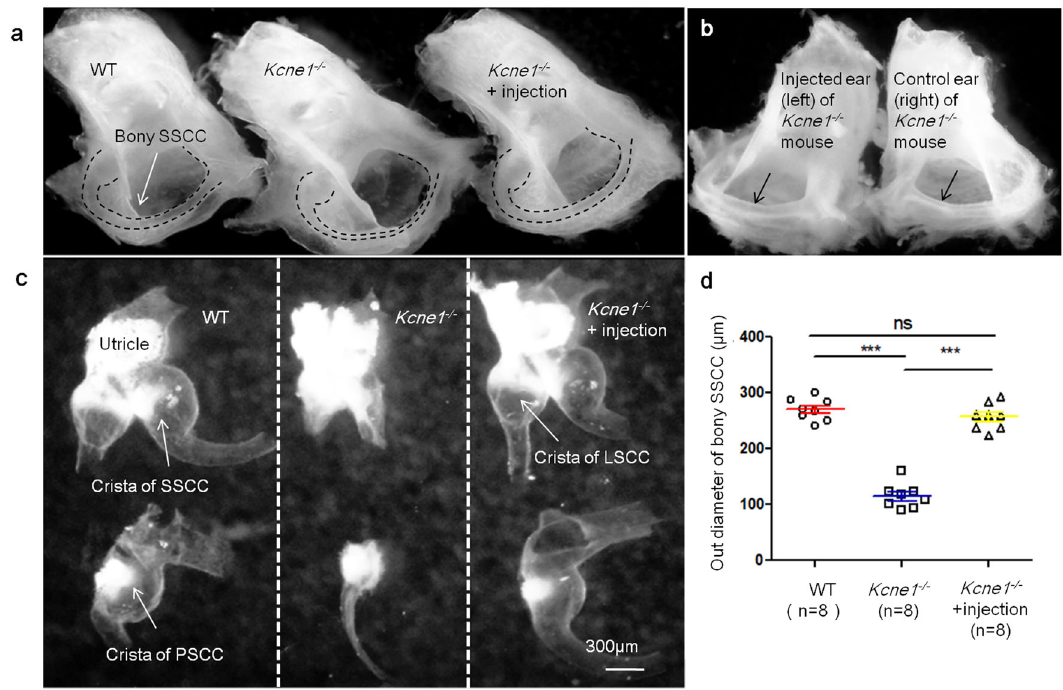
Fig. 3 Morphology of semicircular canals and vestibular membranous labyrinths in WT, untreated Kcne1 − / − mice, and treated Kcne1 − / − mice at P30 ( n = 8 in each group). a Comparison of the gross morphologies of bony semicircle canals in WT, untreated Kcne1 − / − mice, and treated Kcne1 − / − mice. Border of bony superior semicircular canal (SSCC) is outlined by dashed lines. b Gross morphologies of bony posterior semicircular canal (PSCC) in left and right ear of treated and untreated ears of the same Kcne1 − / − mouse. Arrows point the region where the diameters of the semicircular canals were measured. c Gross morphologies of vestibular membranous labyrinths in WT, untreated Kcne1 − / − ear, and treated ears of Kcne1 − / − mice. d Quanti fi cation of the outer diameter of bony SSCC in WT, untreated Kcne1 − / − mice, and treated Kcne1 − / − ears as labeled ( n = 8 in each group, p < 0.0001 in WT ears, and p < 0.0001 in treated Kcne1 − / − ears, comparing to untreated Kcne1 − / − ears, two-sided Student ’ s t tests). ***: p < 0.001. Data are shown as mean ± SEM. Source data are provided as a Source data fi